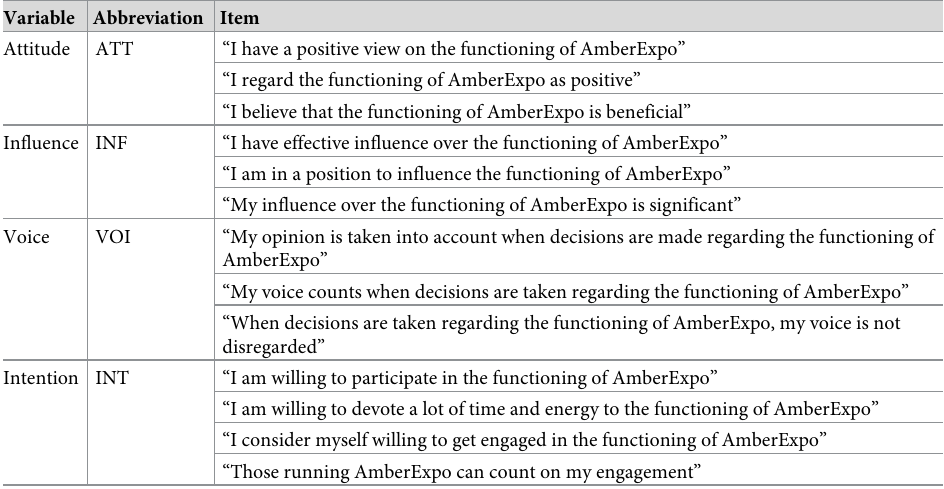
Table 2. List of the items used in the research instrument. Variable Abbreviation